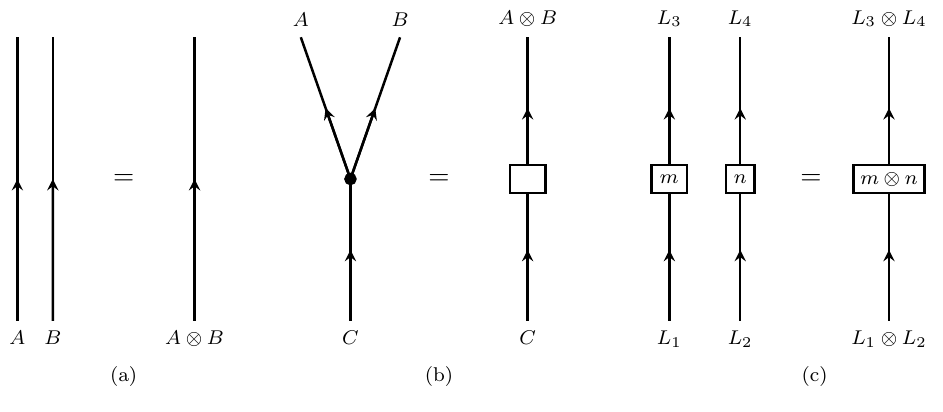
Figure 8 . Fusion: (a) Fusion of line defects gives rise to the tensor product of objects. (b) Three line defects coming together with a local operator placed at the point of intersection can be interpreted as a morphism from one line defect to the tensor product of other two line defects. (c) Local operators between lines can also be fused to give rise to tensor product of morphisms.